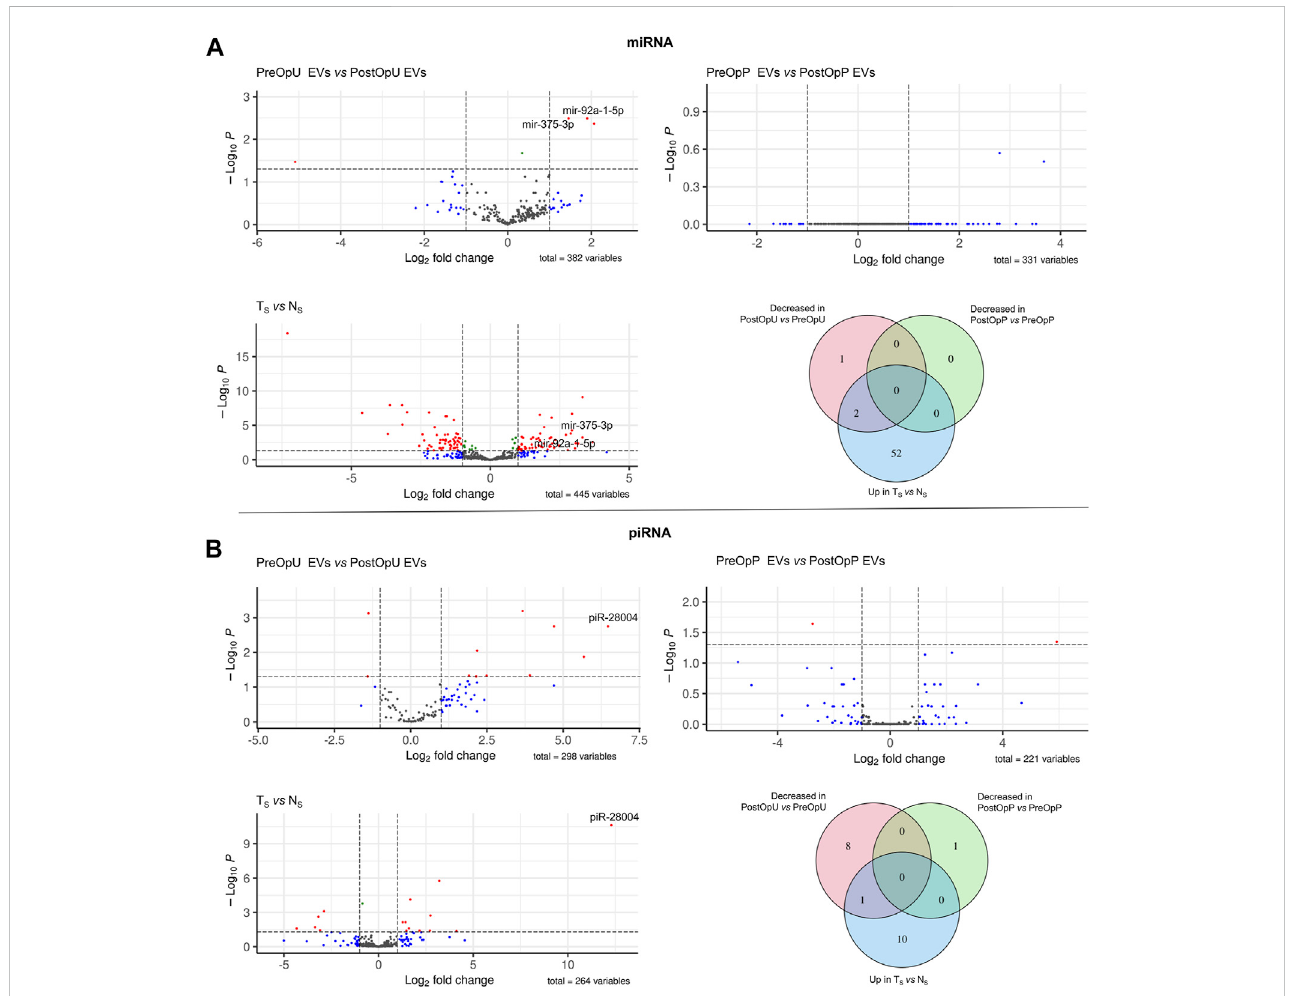
FIGURE 3 DifferentialexpressionanalysisofsmallRNAs. (A) DifferentialexpressionanalysisofmiRNAsand (B) piRNAs.Volcanoplotsdepictsigni fi cantdifferencesin the pre-operation urinary or plasma EVs as compared to the post-operation EVs, and in small RNA libraries prepared from tumor (T S ) and normal prostate tissues(N S ).VenndiagramsshowthenumbersofsmallRNAsoverexpressedintumortissuesvs.normalprostatetissues(UpinT S vs.N S ),decreasedinthepost- operation urinary EVs as compared to pre-operationurinary EVs and decreased inthe post-operationplasma EVs as compared to pre-operationplasma EVs (Log2FC > 1 and adj. p -value ≤